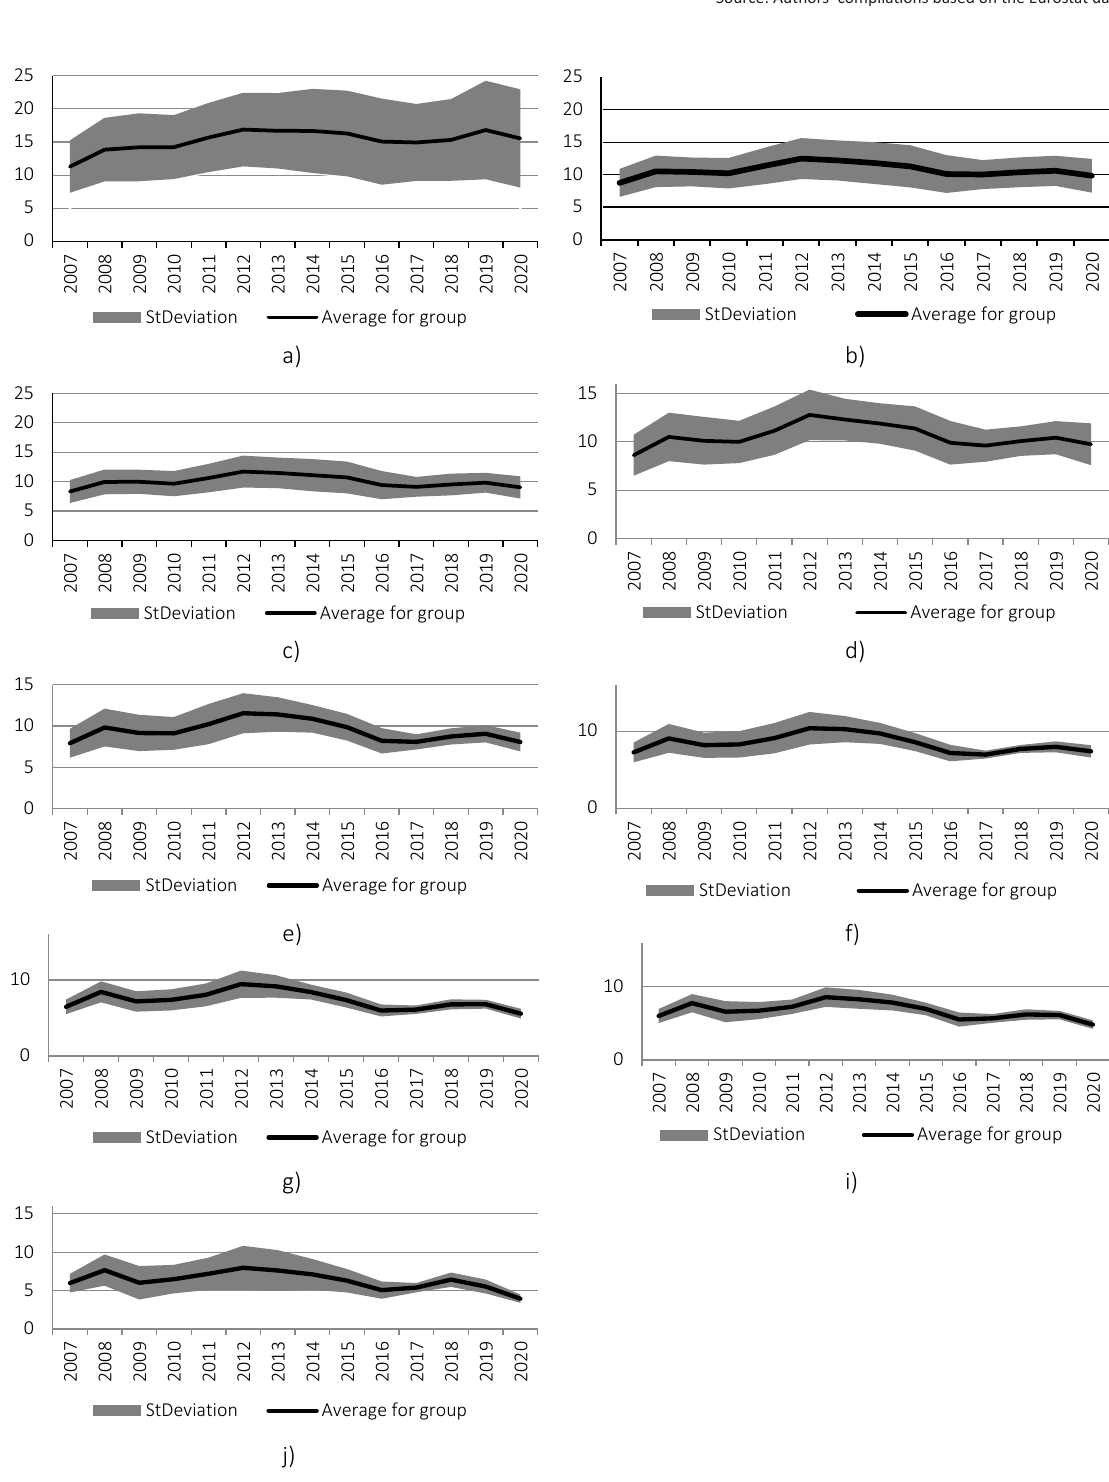
Figure 5. Price convergence for